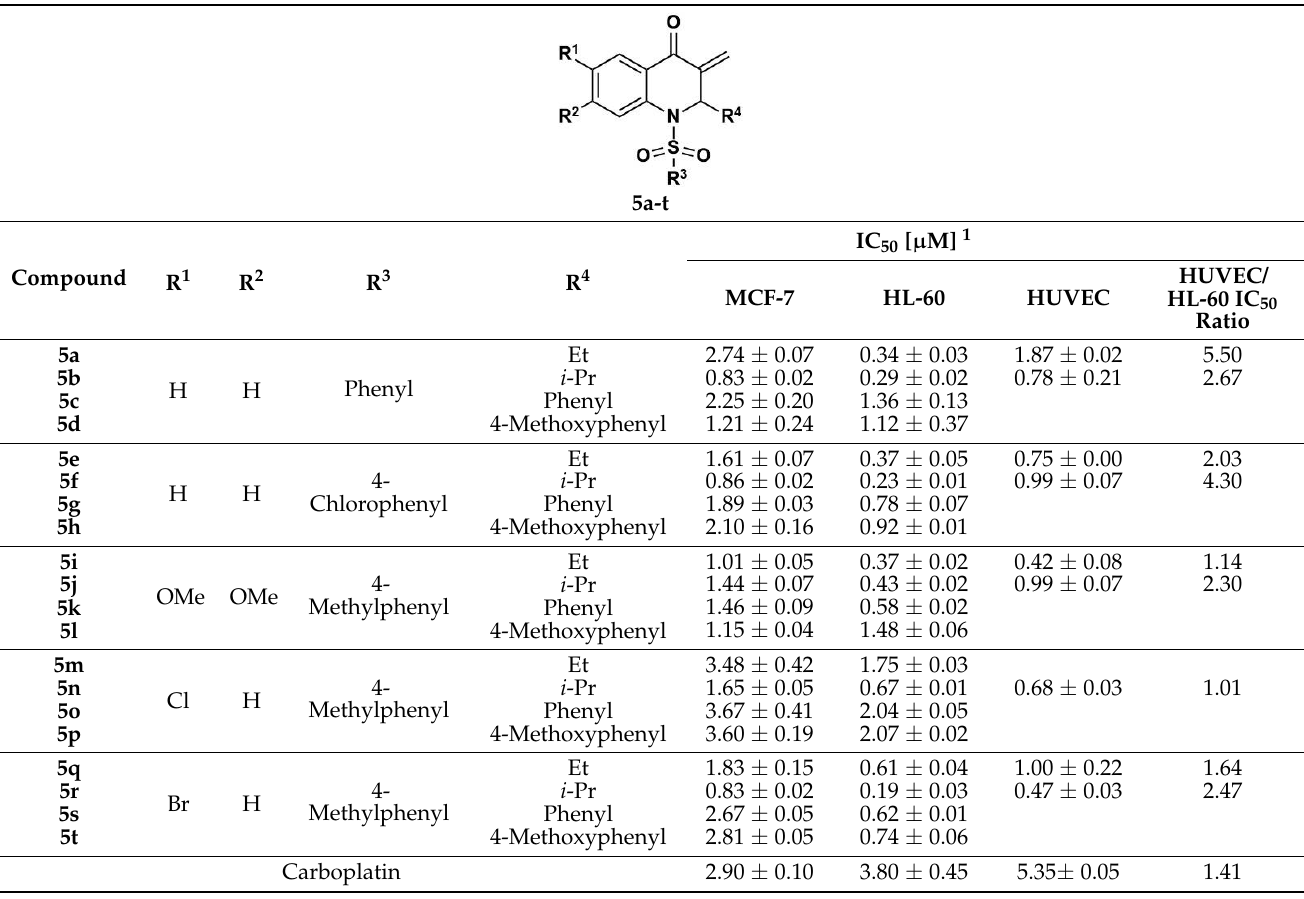
Molecules 2022 , 26 , x FOR PEER REVIEW 5 of 16 Table 2. In vitro cytotoxic activity of 3-methylidene-1-sulfonyl-2,3-dihydroquinolin-4(1 H )-ones 5a-t tested on two cancer (MCF-7, HL-60) and one normal (HUVEC) cell lines.